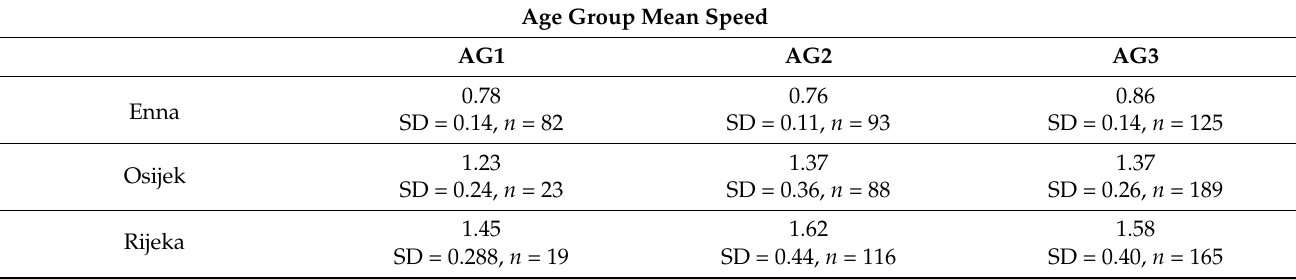
Table 7. Children pedestrians’ mean speed–depending on children’s age.